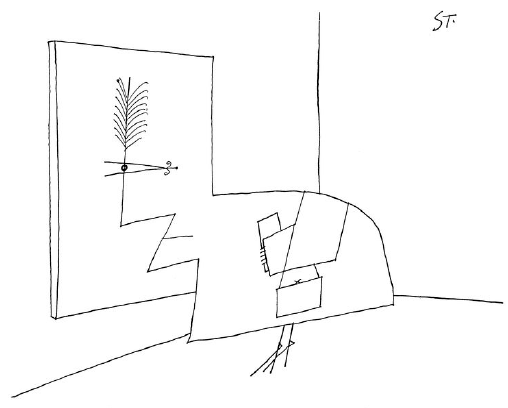
Figure 16. S. Steinberg, from The Discovery of America ,